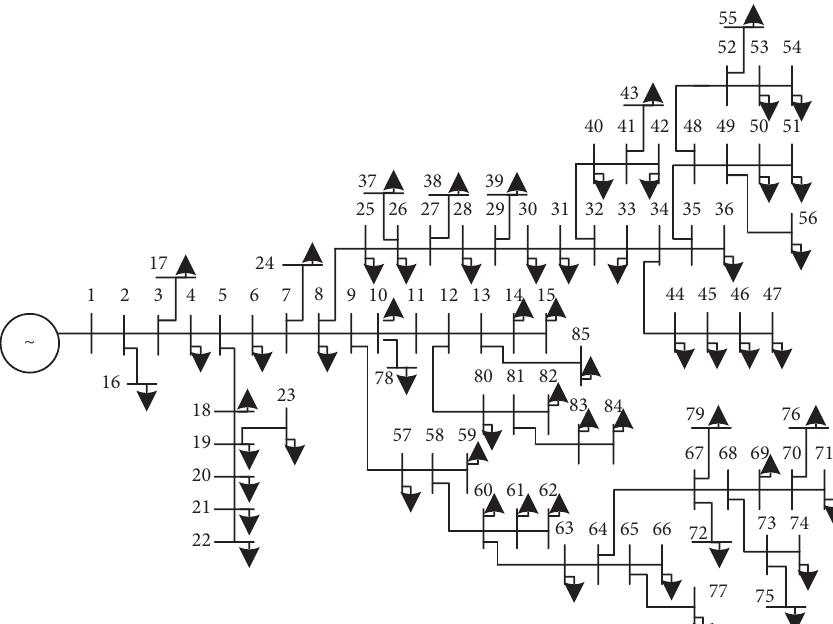
Figure 18: The 85-bus distribution